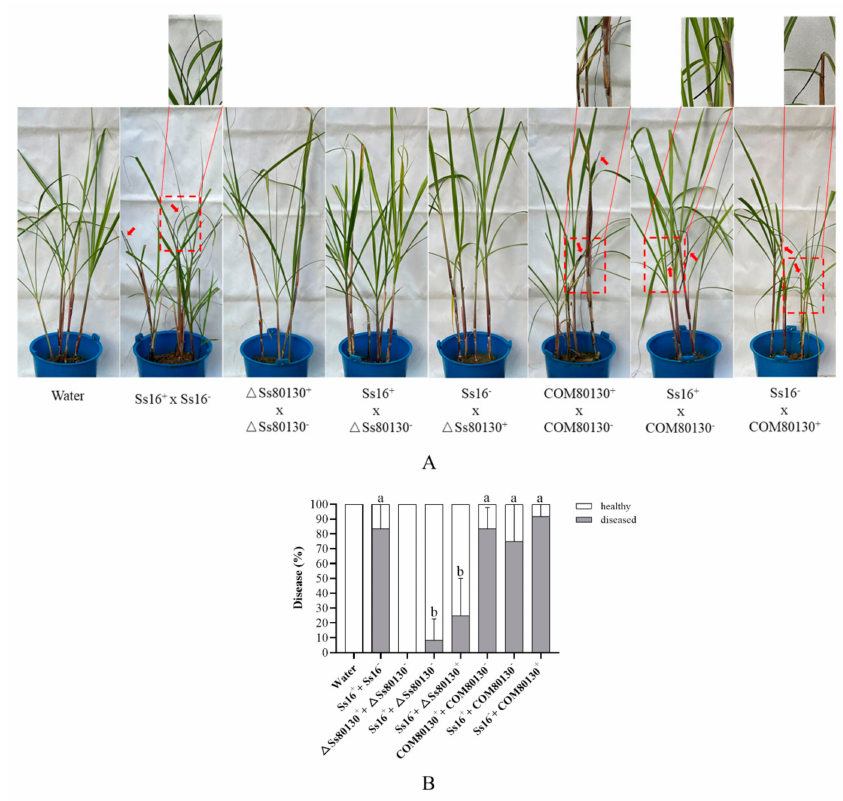
Figure 9. Effects of the SsCI80130 gene in the pathogenicity of S. scitamineum . ( A ) Symptoms of sugarcane smut. The black whips are marked with a red arrow, and the enlarged view of black whips are marked with a red dashed box. ( B ) Final incidence counted after four months of cane plant growth. Bars indicate the standard error. Different lowercase letters represent a difference at the 0.05